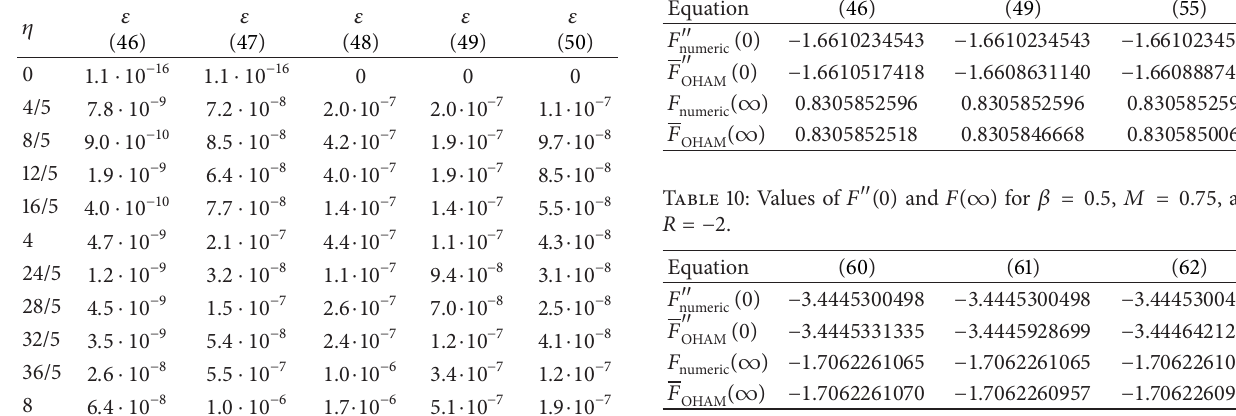
Table 9: Values of 𝐹 󸀠󸀠 (0) and 𝐹(∞) for 𝛽 = 0.5 , 𝑀 = 0.75 , and 𝑅 = 0.25 .